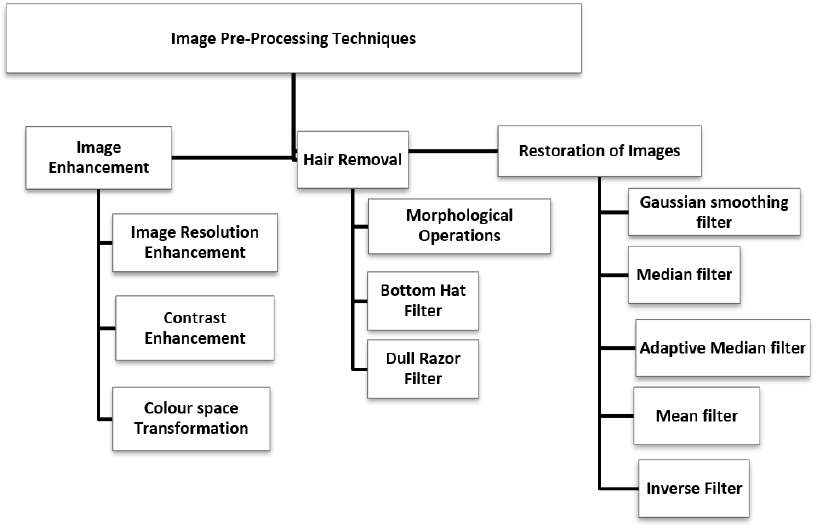
Figure 2. Types of Image Pre-Processing.